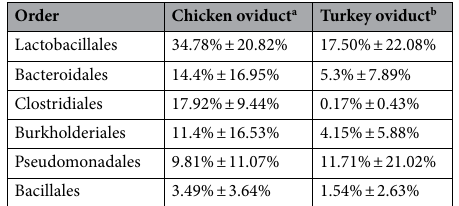
Table 1. Composition of the oviduct in chicken and turkey at the order level of some of the dominant bacteria. a Shterzer et al. b Data from this study.